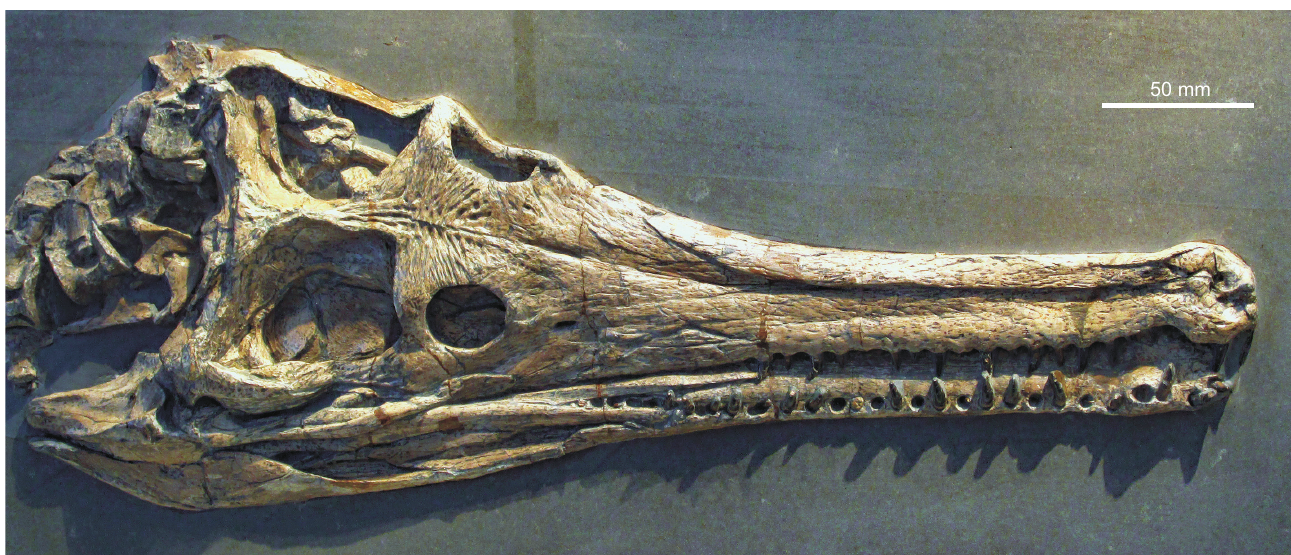
Fig. 6. Photograph of teleosauroid thalattosuchian specimen (UH 7), lower Toracian of Holzmaden (southwestern Germany), which was described